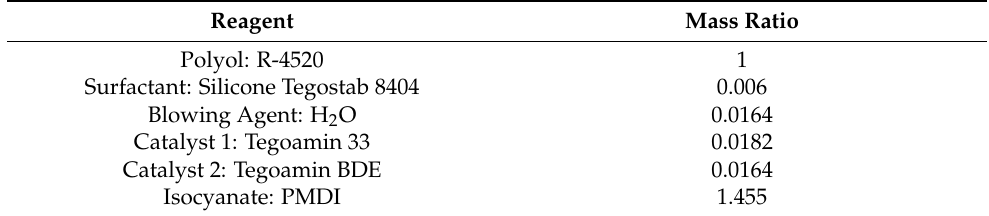
Table 1. Mass ratio of the reactants for the synthesis of polyurethane foams without microcapsules. Reagent Mass Ratio Polyol: R-4520 1 Surfactant: Silicone Tegostab 8404 0.006 Blowing Agent: H 2 O